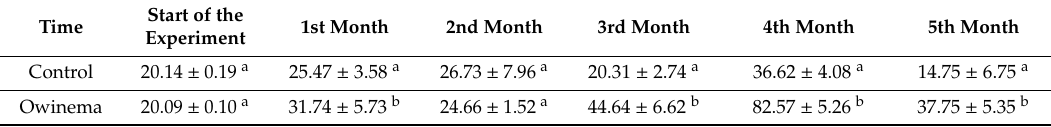
Table 3. Mean biomass of E. fetida (g ∙ container − 1 ± SD) in experimental ecological boxes depending on the presence of Steinernema feltiae (50 mln larvae m − 2 ) during a 5 month experiment.